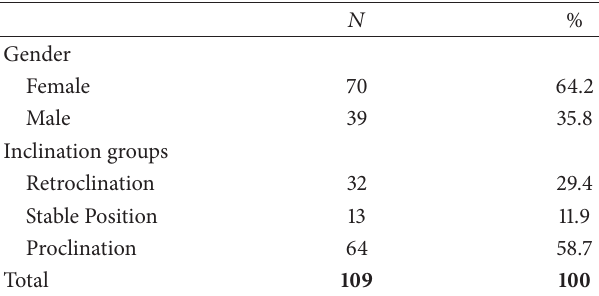
Table1:Distributionofdataaccordingtothegenderandinclination groups.